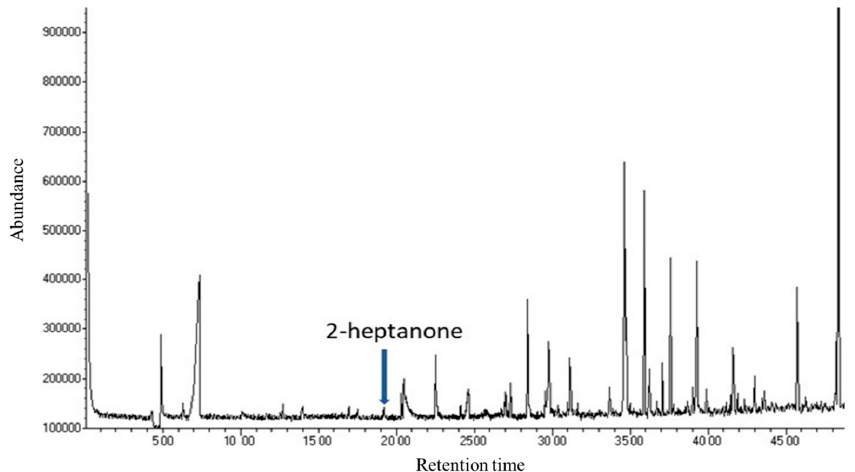
Figure 1. GC-MS chromatogram of the Acetobacteraceae bacterium strain IM_G(L)3 culture